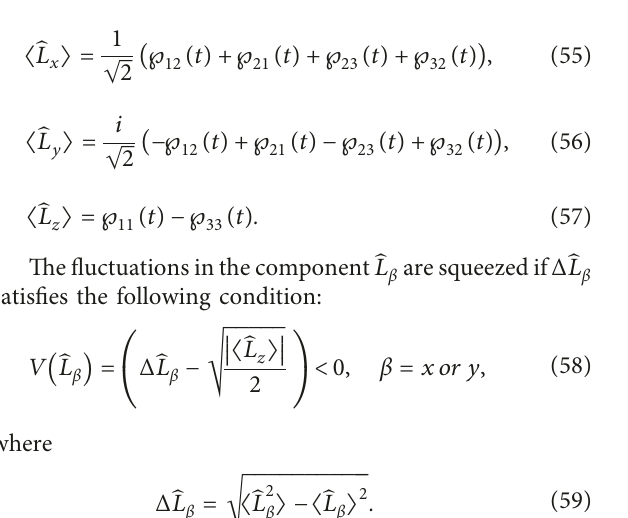
L E L x ) and y ) as a function of the scaled time ( ( (cid:31) (cid:31)